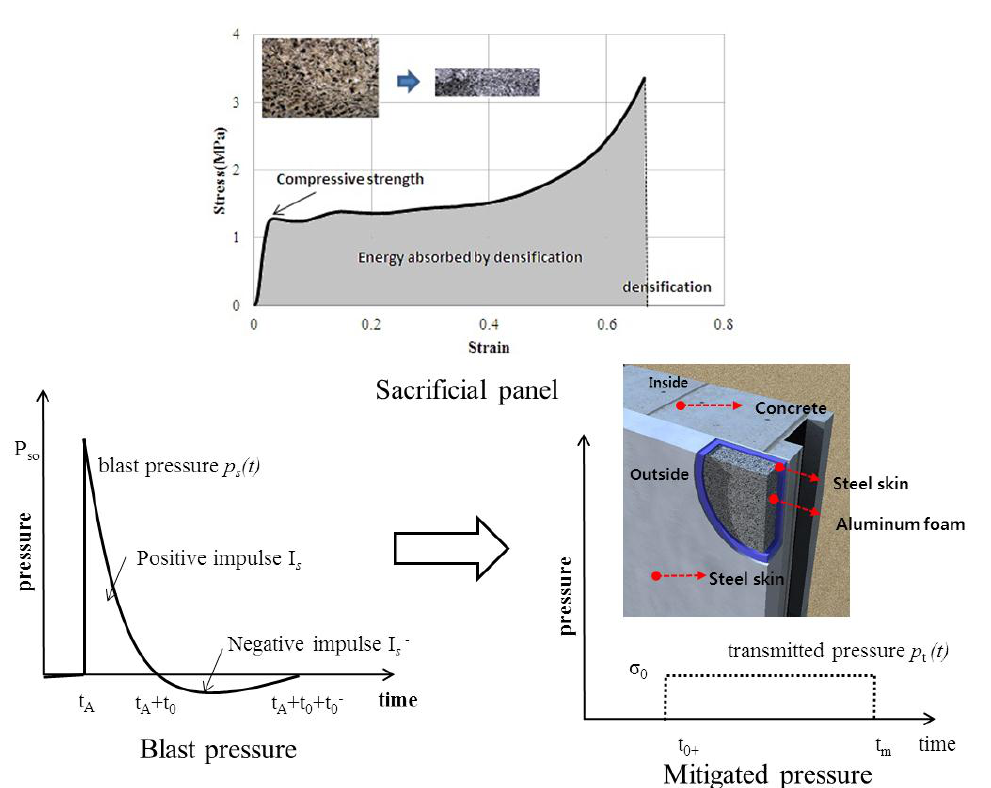
Figure 1. Mitigation of blast pressure by aluminum foam